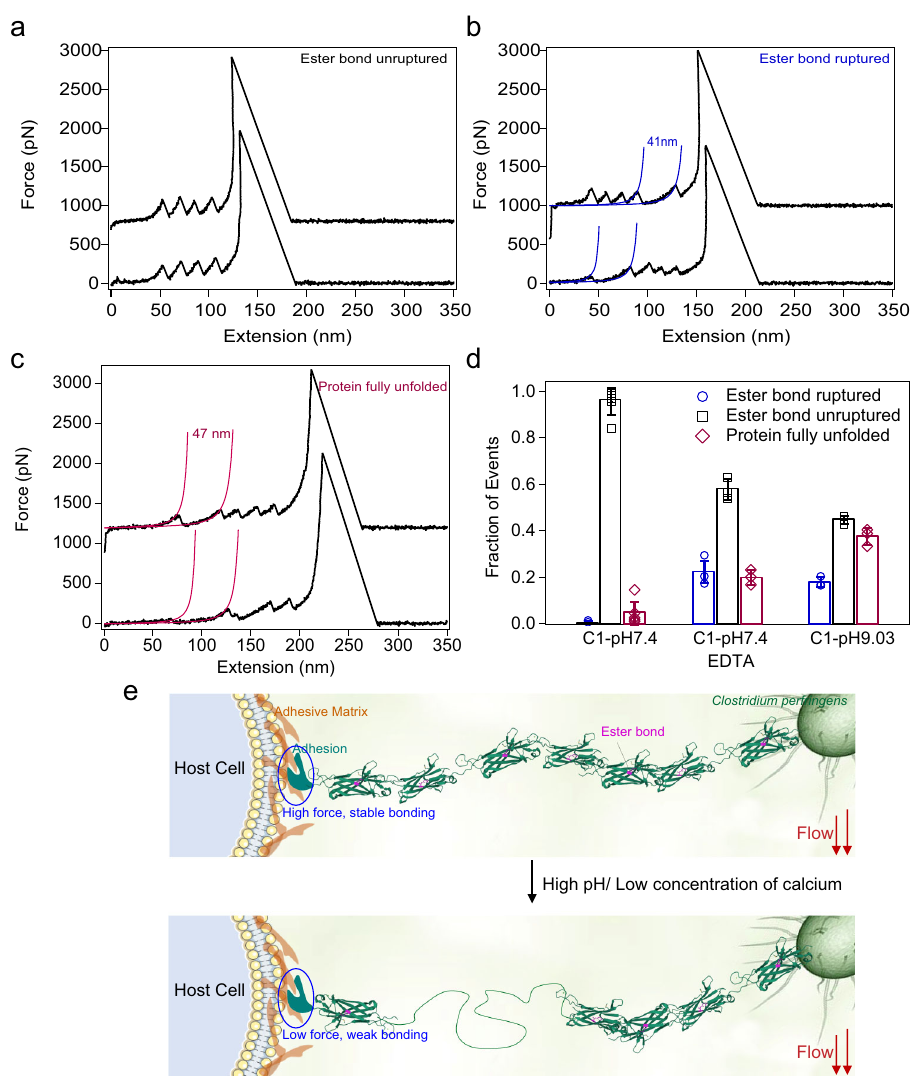
Fig. 7 Mechanical features of C1 at a basic pH of 9.0 and in the presence of EDTA (10 mM). a Representative force – extension curves of the “ Ester bond unruptured ” group. The traces show only four GB1 unfolding events without the signature of C1 unfolding or ester bond rupture. b Representative force – extension curves of the “ Ester bond ruptured ” group. Two populations of unfolding events were observed: Four peaks with a Δ L c of 41 nm relate to GB1 unfolding and an additional one with a Δ L c of 41 nm corresponds to the rupture of the ester bond. c Representative force – extension curves of the “ Protein fully unfolded ” group. Except for the four GB1 unfolding events, there is an additional peak with Δ L c of 47 nm (colored in red, upper trace) or a spacer corresponding to the unfolded of C1 (lower trace). d The statistics of the three types of events of C1 at pH 7.4 and pH 9.0 and in the presence of EDTA (pH 7.4). The numbers of tests in three conditions are 3, 3, 3 for pH 7.4, pH 7.4 with EDTA and pH 9, respectively. Error bars represent SD. e Proposed mechanism for the function of ester bond containing proteins during bacteria invasion. This experiment was repeated three times independently with similar results. Source data are provided as a Source Data fi